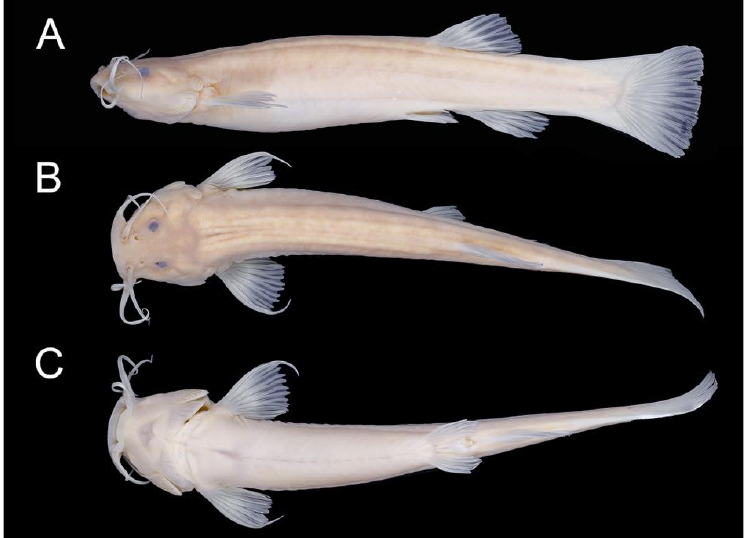
Figure 10. Trichomycterus longibarbatus , UFRJ 3368, topotype, 52.9 mm SL: ( A ) lateral, ( B ) dorsal, and ( C ) ventral views.